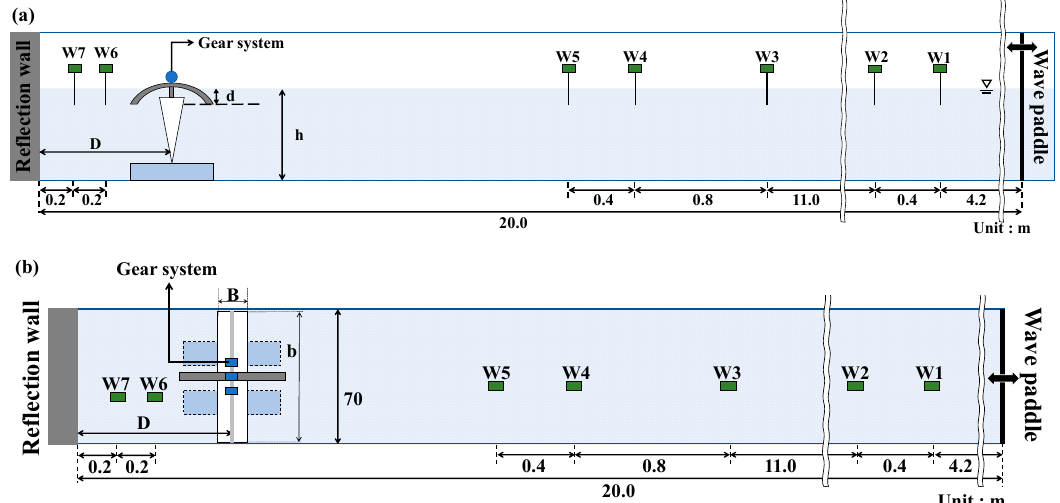
Figure 1. Schematic sketch of the experimental setup: ( a ) side view, ( b ) plan view. W1–W7 denote the water level gauges; h is the water depth; D indicates the distance between the flap and reflection wall; d is the submergence depth of the flap; and B and b are the width and length of the upper part of an inverted triangular prism, respectively.